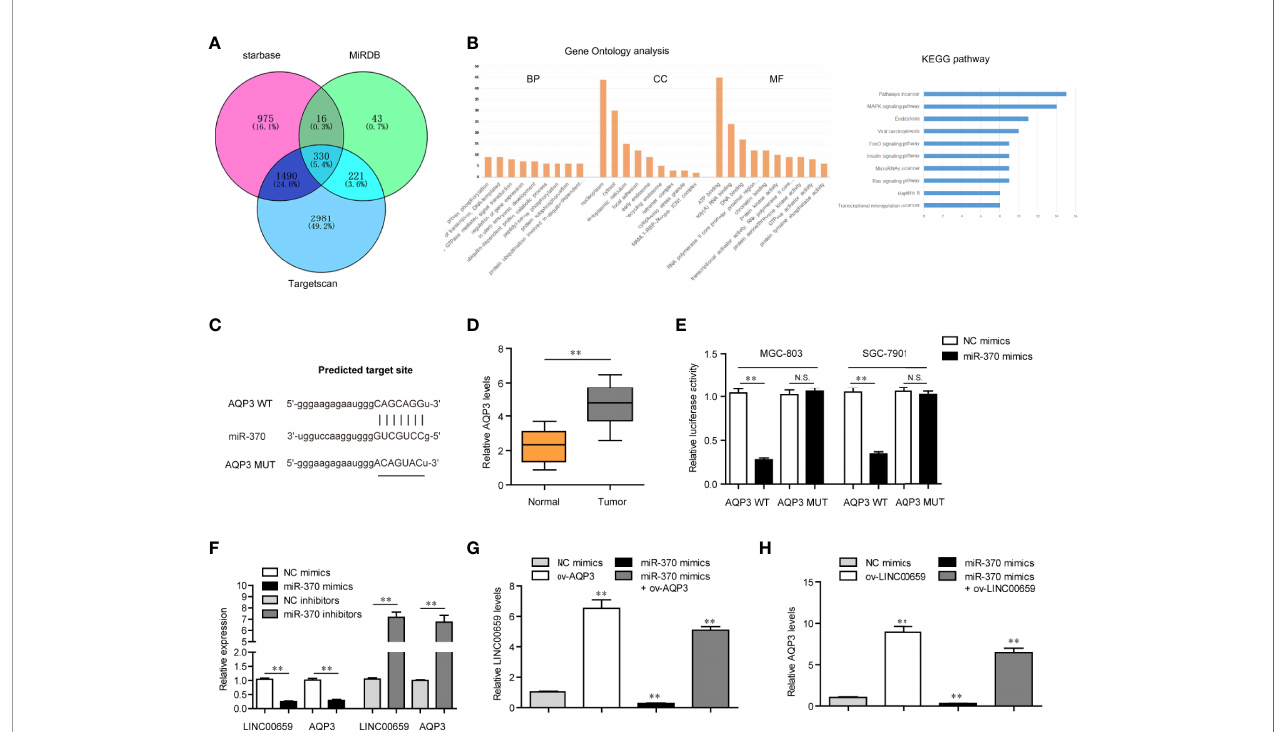
FIGURE 6 | LINC00659 modulated AQP3 expression via sponging miR-370 in GC cells. (A) Venn diagram of common target genes using three classical predicting algorithms. (B) Gene ontology (GO) and KEGG pathway analysis of these commonly predicted genes. (C) The potential target site for miR-370 in 3 ’ UTR of AQP3 mRNA. (D) qPCR detected AQP3 expression in 120 GC samples. (E) Luciferase activity detection. (F) qPCR analyses detected LINC00659 and AQP3 levels. (G) qPCR examined LINC00659 levels in MGC-803 cells after various treatment. (H) qPCR determined AQP3 expression in MGC-803 cells after various treatments. **P < 0.01. N.S., no signi fi